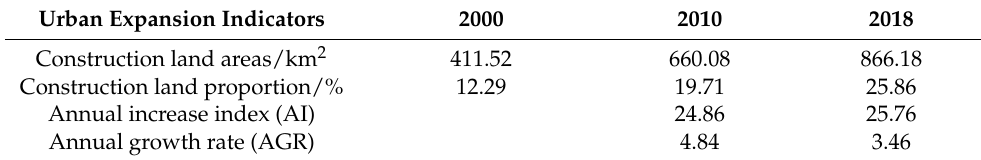
Table 5. Characteristics of urban expansion from the city center in 2000–2018.